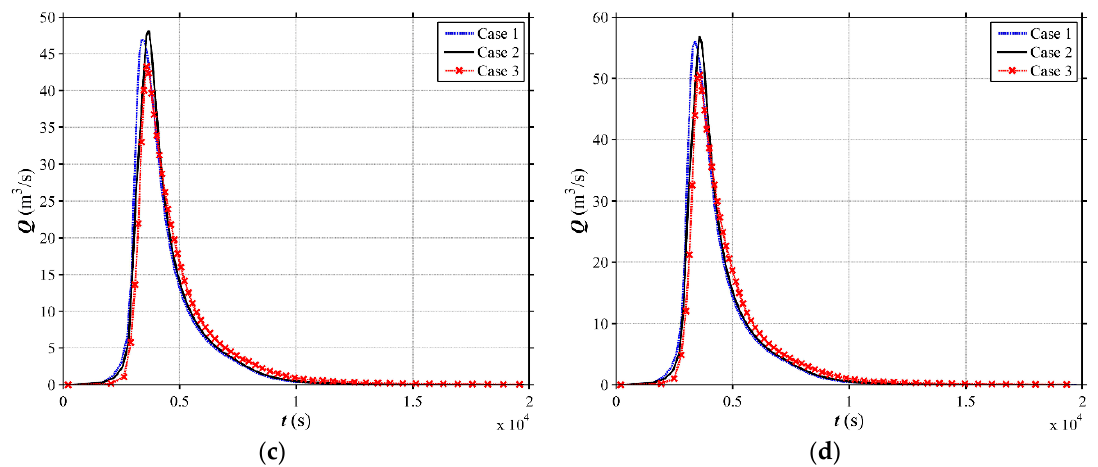
Figure 7. Simulated hydrographs at the outlet for different land use scenarios in the V-shaped catchment with i 1 = 0.05. ( a ) 2-year; ( b ) 10-year; ( c ) 50-year; ( d ) 100-year.